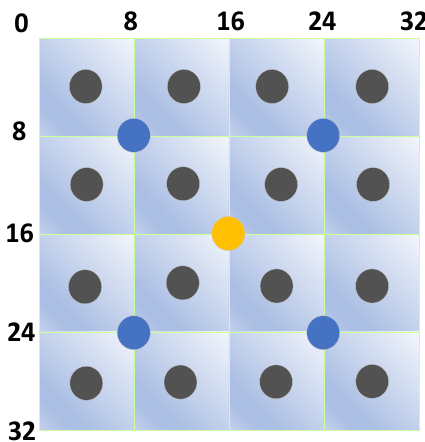
Figure 2. The structure of the deep convolutional network in this paper.